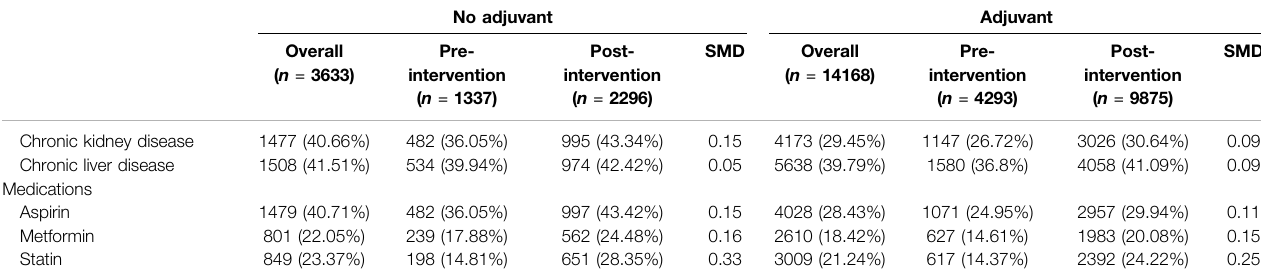
Frontiers in Pharmacology |